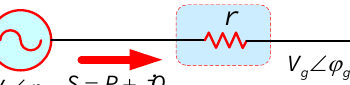
Figure 1. Equivalent circuit of a distributed generator (DG) unit connected to the common bus.